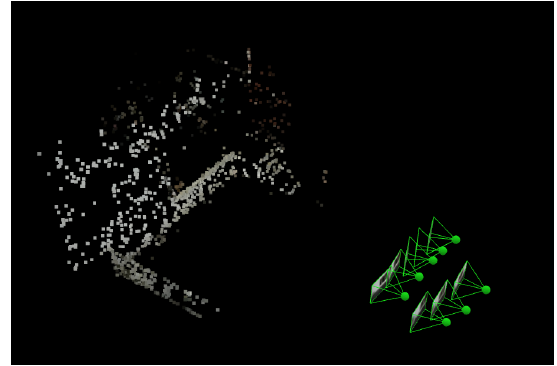
Figure 5. Calibration polygon